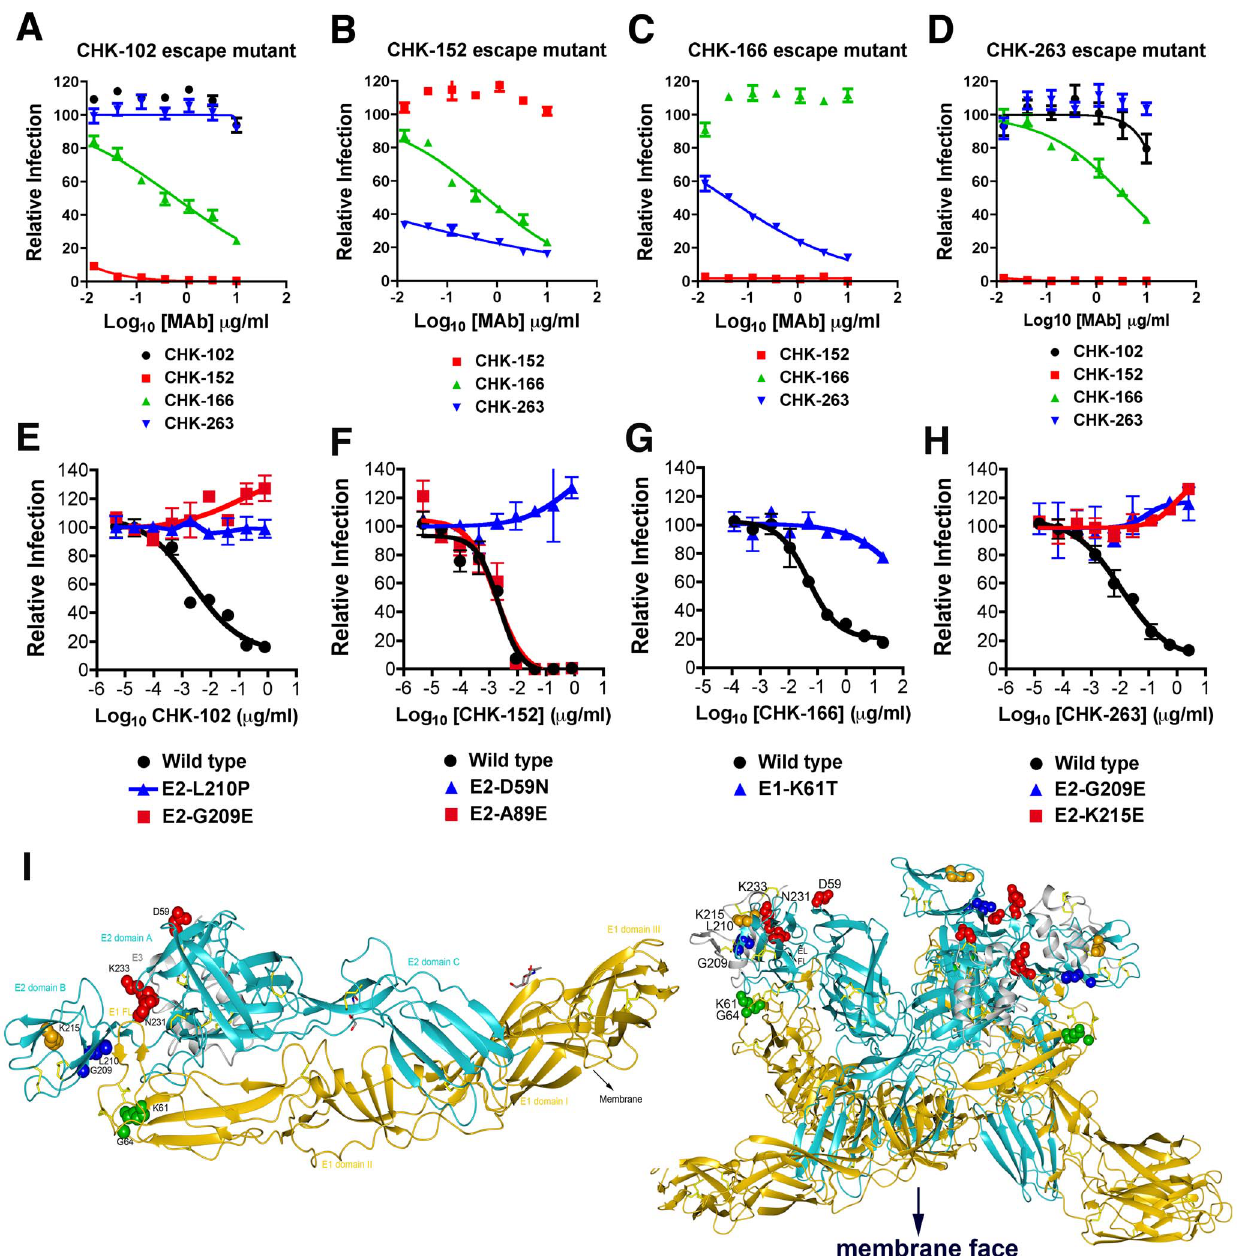
Figure 6. Characterization and mapping of neutralization escape mutants. A–D . FRNT assay with bulk virus obtained after three to six passages under selection of ( A ) CHK-102, ( B ) CHK-152, ( C ) CHK-166, or ( D ) CHK-263 on Vero cells. Bulk virus also was tested for infectivity in the presence of the non-selecting MAbs. Results are representative of two to three independent experiments performed in triplicate. E–H . Confirmation of resistant phenotype with SFV-CHIKV-GFP containing the indicated single engineered point mutations. Serial dilutions of MAb were incubated with chimeric SFV-CHIKV virus (WT or mutant stocks) for one hour at room temperature. MAb-virus complexes were added to Vero cells plated in 96-well plates and incubated at 37 u C. After 8 hours cells were trypsinized, fixed, and the number of GFP-positive, infected cells was assessed by flow cytometry. Curves are representative of 2 to 3 independent experiments. I . Epitope mapping of anti-CHIKV MAbs on the crystal structure of the mature envelope glycoprotein complex (PDB code 3N44). ( Left ) The domains on E2 (cyan) and E1 (gold) are indicated, and the fusion loop on E1 (E1 FL) is delineated. Amino acid residues of neutralizing MAbs were determined by escape selection, sequencing, and reverse genetic confirmation. CHK-102 and CHK-263 recognize the B domain on E2, CHK-152 recognizes a residue on the wings of the A domain on E2, and CHK-166 recognizes an amino acid in domain II of E1 proximal to the conserved fusion loop. ( Right ) The mature envelope glycoprotein docked onto the trimer conformation (PDB code 2XFB) that is present on the virion. E3, E2, and E1 and the escape residues are colored as in the left panel. Neutralization escape residues are readily accessible on the top of the trimer, distal to the viral membrane.